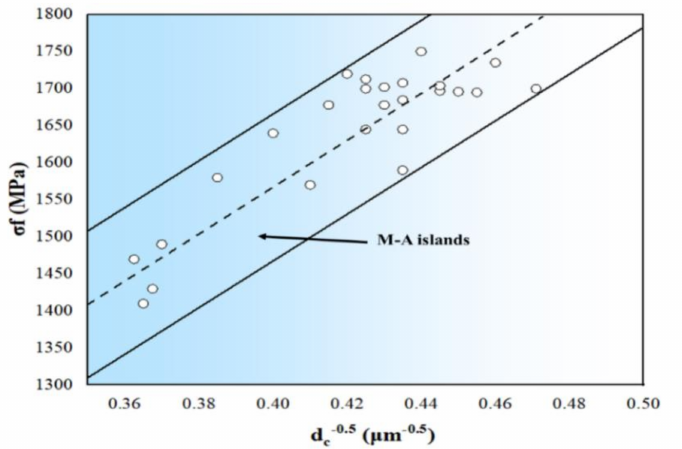
Figure 12. Local fracture stress σ f as a function of M − A constituent for three-point bend test